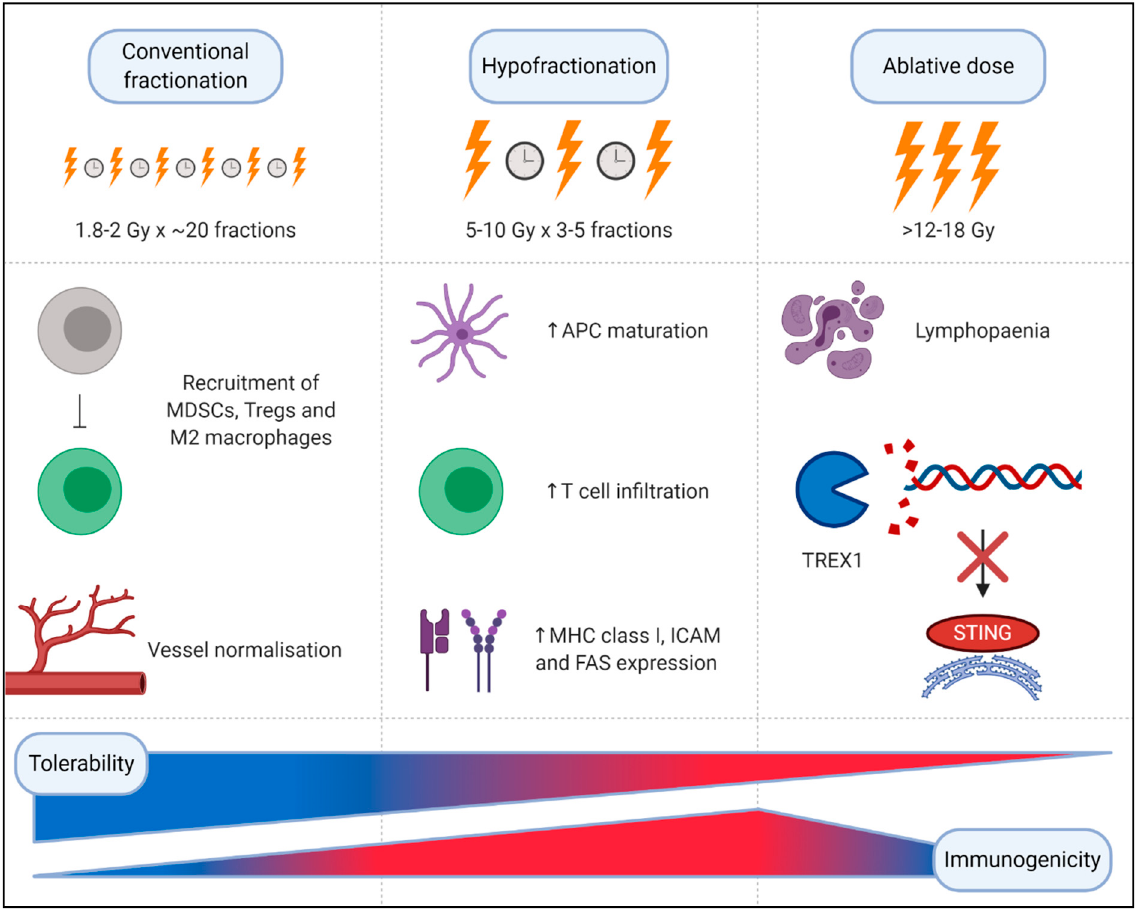
Figure 4. Optimising radiation dose and delivery for optimal immunogenicity. Small doses of radiation delivered in conventional fractionated radiotherapy are believed to have immunosuppressive effects in the tumour microenvironment; accumulation of immunosuppressive cell types such as myeloid-derived suppressor cells (MDSCs), regulatory T cells (Tregs) and M2 macrophages repress anti-tumour immunity. This immunosuppressive effect is somewhat counterbalanced by the normalising effect low dose radiation has on the tumour vasculature. Higher doses of radiation, such as those used in hypofractionation, can have a stimulatory immunogenic effect mediated by increased antigen presenting cell (APC) maturation, in addition to augmented T cell infiltration and enhanced expression of immunogenic proteins including MHC class I, ICAM and FAS on tumour cells. However, once the dose of radiation surpasses 12–18 Gy, immunogenicity is compromised: TREX1, an exonuclease, is induced leading to degradation of cytoplasmic DNA, thus negatively regulating the cGAS-STING pathway.